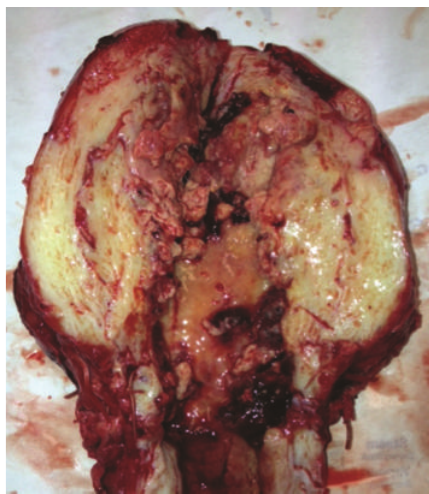
Figure 3: Post-operative uterus examination demonstratingexten- sive necrosis of the myometrium with acute inflammation, extend- ing from the lower uterine segment to the uterine fundus.